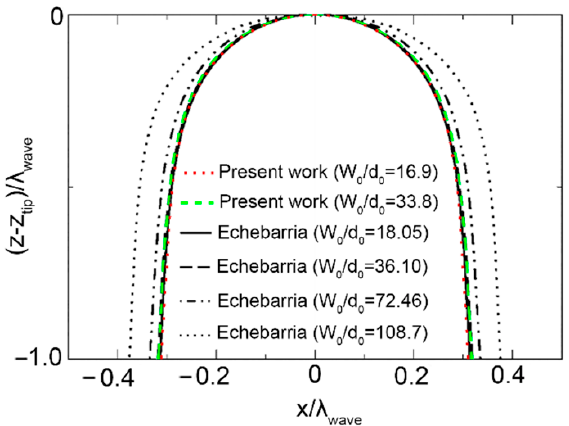
Figure 4. Comparison of simulated results with results from Echebarria et al . [50].